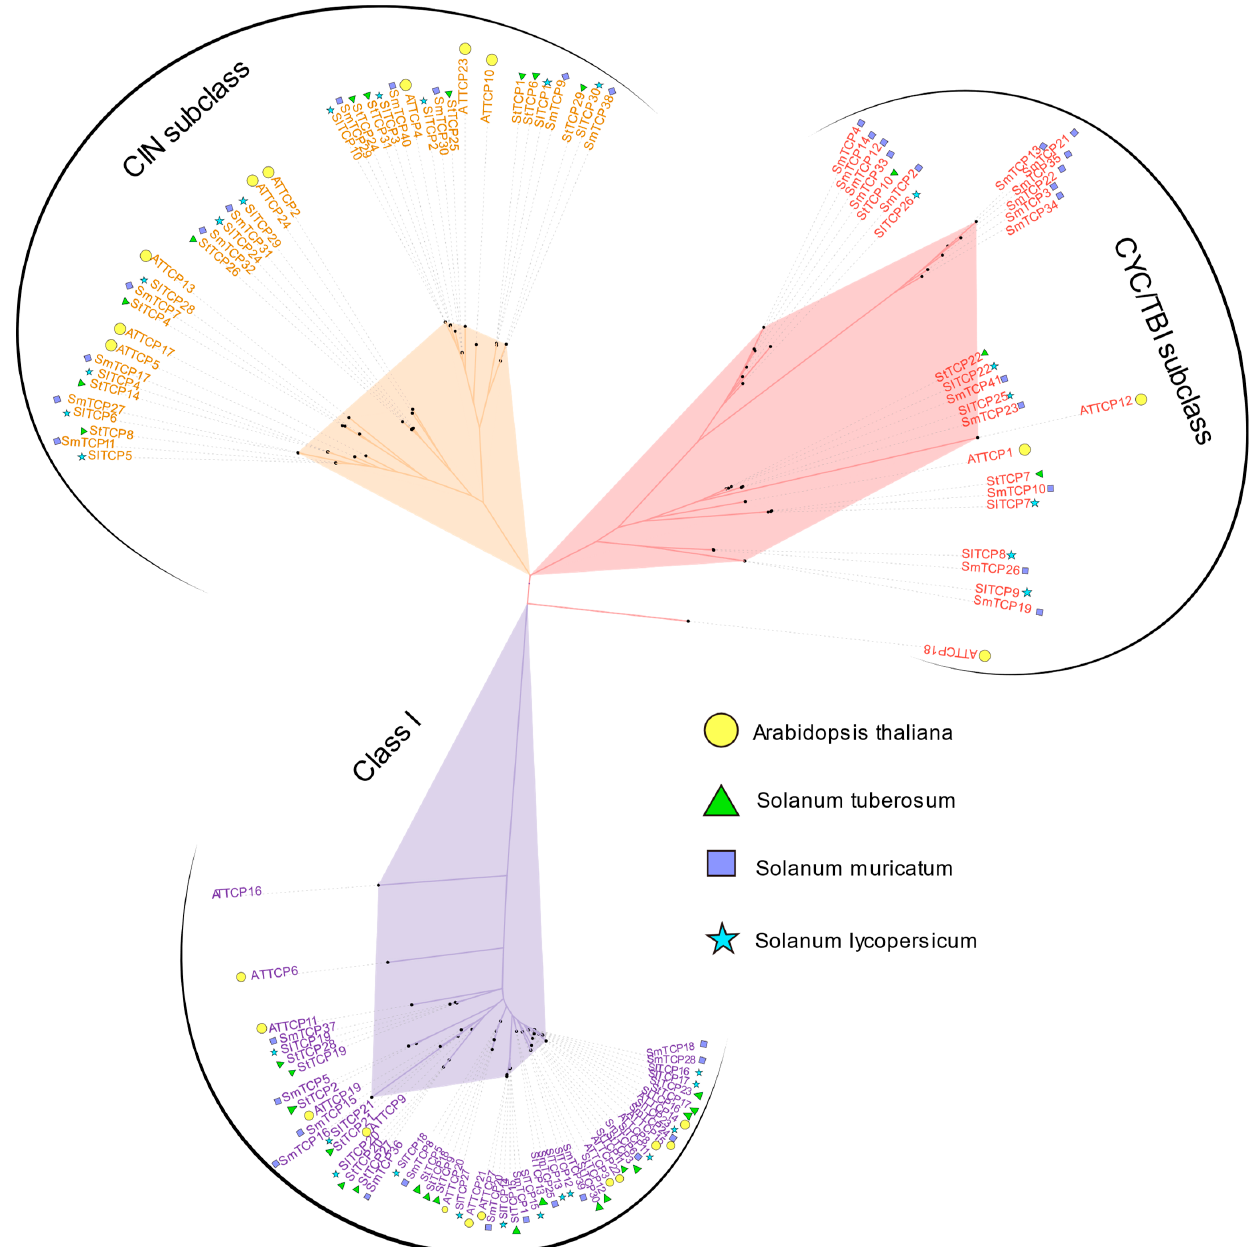
Figure 2. Construction of phylogenetic trees for S. muricatum , S. lycopersicum , S. tuberosum and A. thaliana . Table 1. Information on members of TCP transcription factor family in S. muricatum .